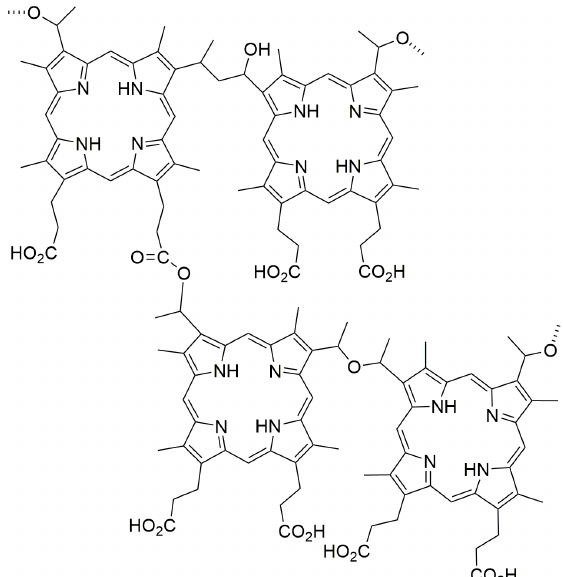
Figure 4 - Generic structure of Photofrin R